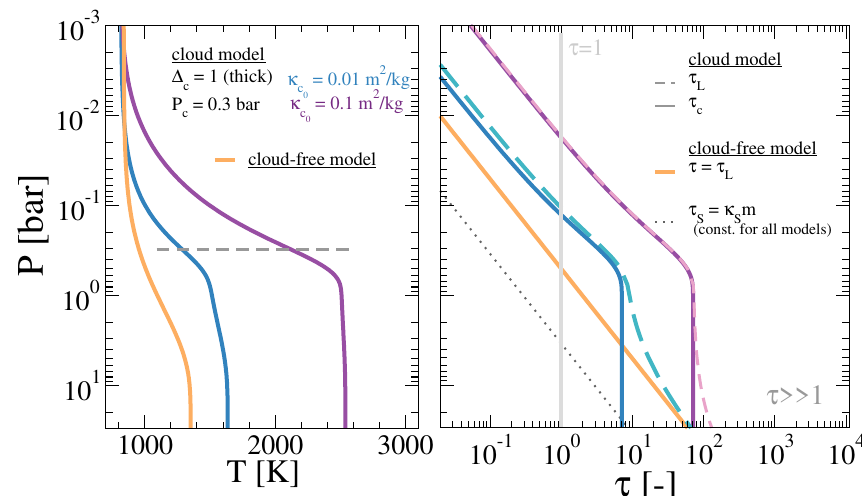
Figure 3. Influence of two cloud decks (optically thin, blue; optically thick, violet, cloud-free, orange) on the P – T relation of WASP-10b for T int = 0 K (left) and P – τ -relation (right) for optical depth τ L (dashed) and cloud optical depth τ c (solid), which contributes to τ L (cf. Equation (49) in [11]). The cloud decks are located at 0.3 bar and are of vertical extension ∆ c = 1.